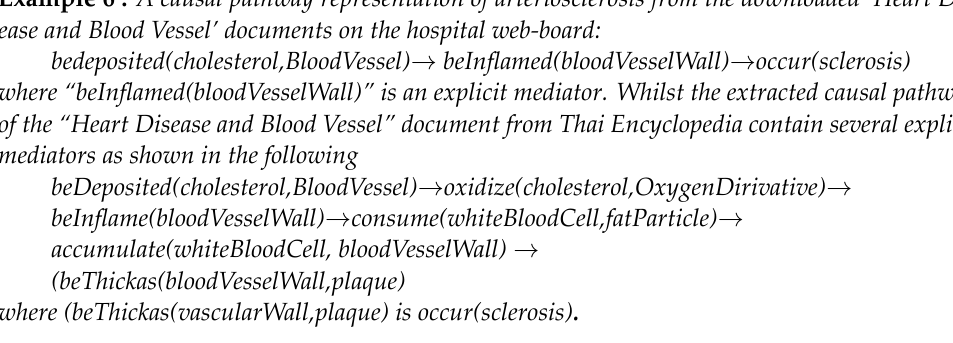
Table 5. The evaluation of the concise and comprehensible representations of Doc and Graph is based on scoring with the Likert scale (1 to 5). Concise Representation Comprehensible Representation Average Score by Doc Average Score by Average Score by Doc Average Score by Disease Group Representation Graph Representation Representation Graph Representation Diabetes and Kidney 3 Heart and